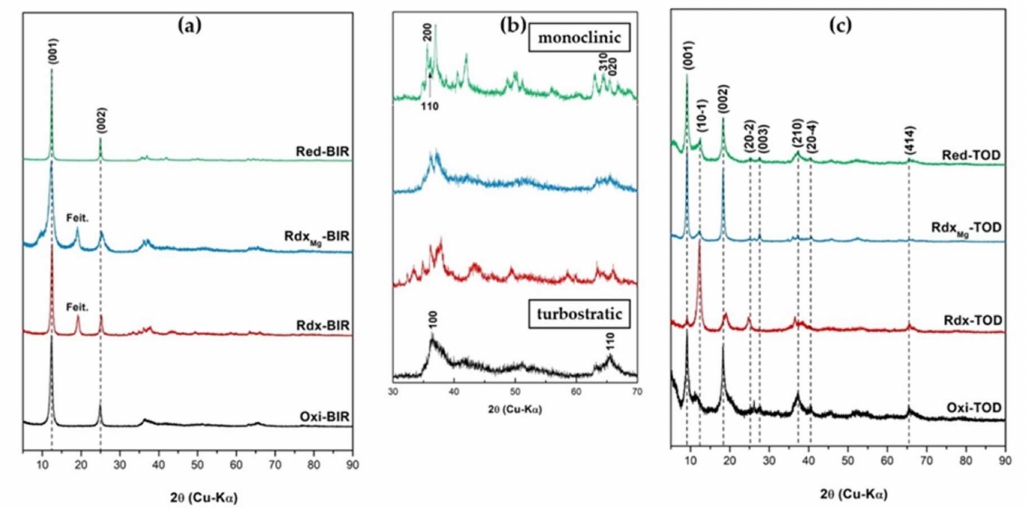
Figure 2. X-ray di ff raction (XRD) patterns of birnessite ( a ) synthesized through the oxidation ((Oxi-BIR)), redox ((Rdx-BIR), (Rdx Mg -BIR)), and reduction ((Red-BIR)) methods. The peaks of birnessite between 30 ◦ and 70 ◦ are separately shown ( b ). The todorokite ( c ) synthesized using each precursor ((Oxi-TOD), (Rdx-TOD), (Rdx Mg -TOD), and (Red-TOD)). The XRD patterns ( a , c ) are scaled by converting to the highest intensity value of